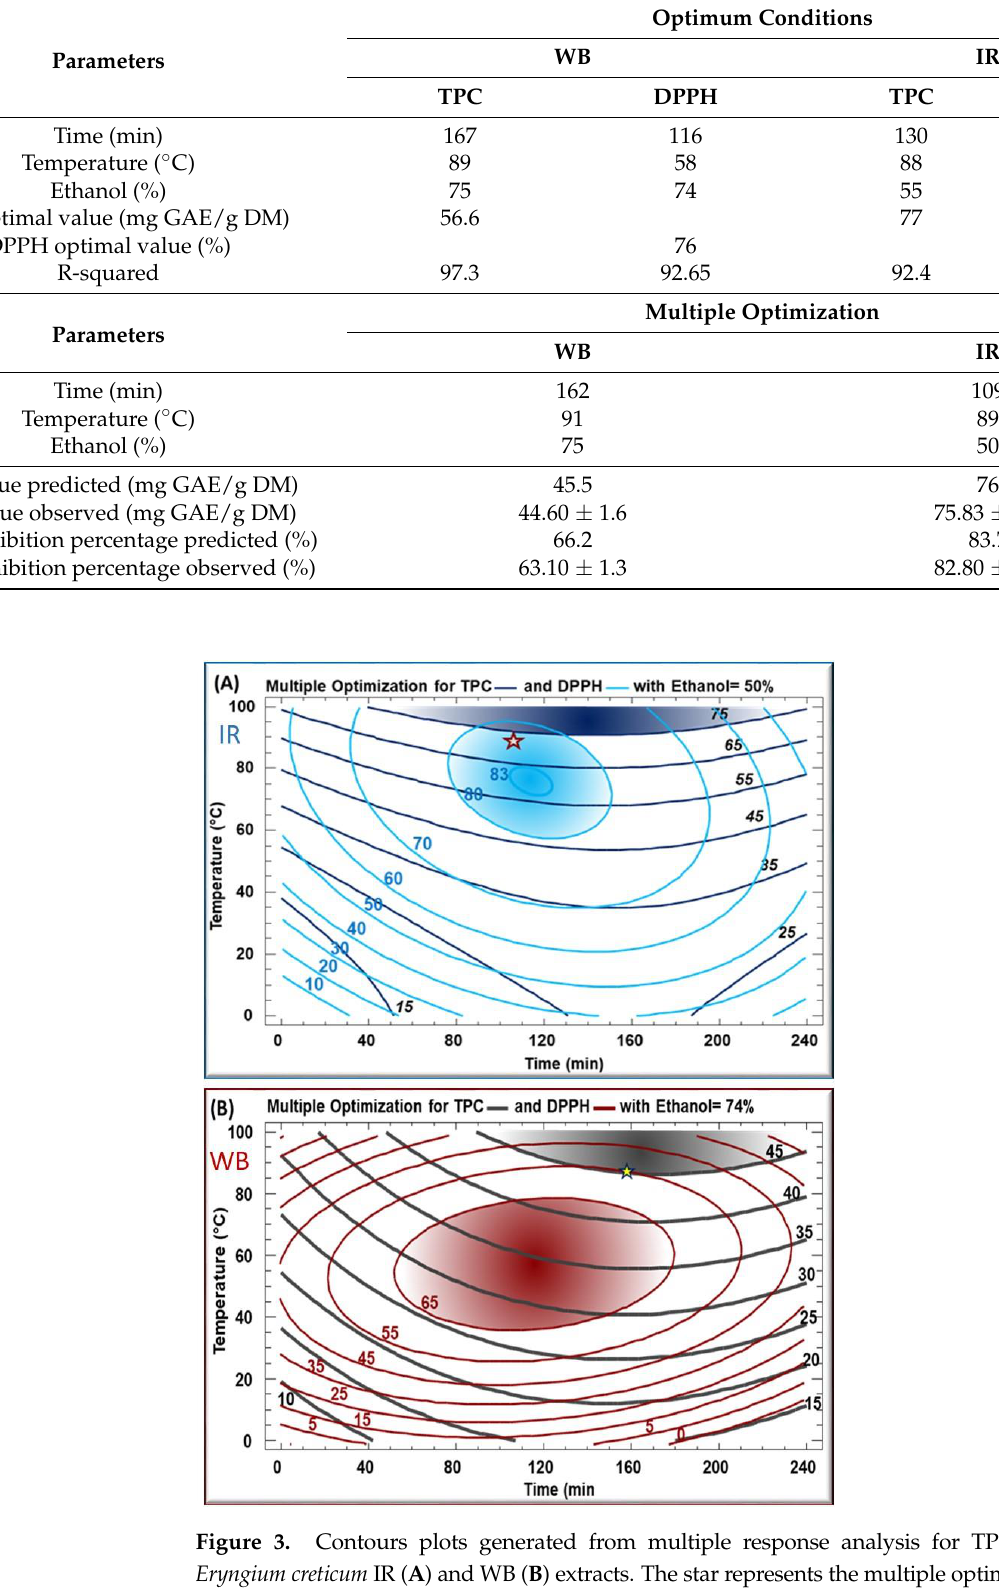
Table 3. Optimum extraction conditions for WB and IR techniques.